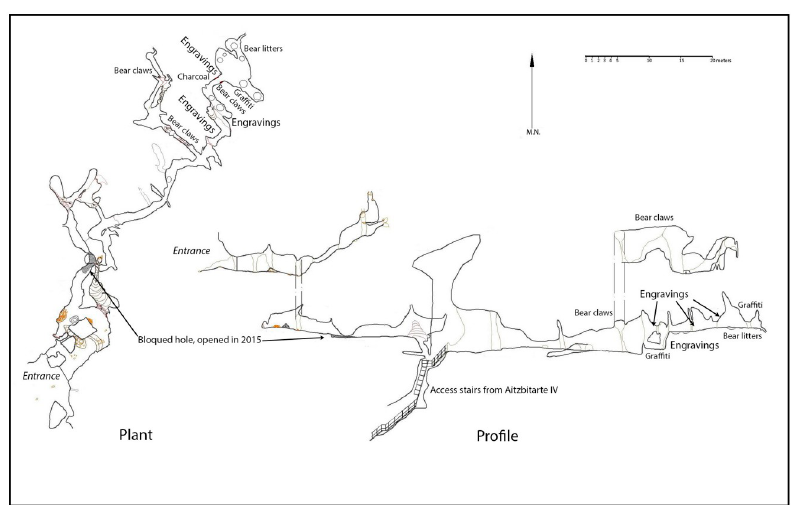
Fig 10. Plan of Aitzbitarte Cave V. The decorated areas are indicated (J. Busselo).